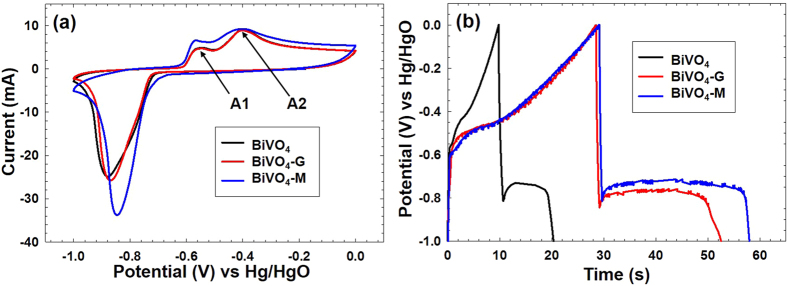
(a) CV curves of BiVO4, BiVO4-G and BiVO4-M at a scan rate of 20 mVs−1, (b) CD profile of BiVO4, BiVO4-G and BiVO4-M at a current density of 7 Ag−1.